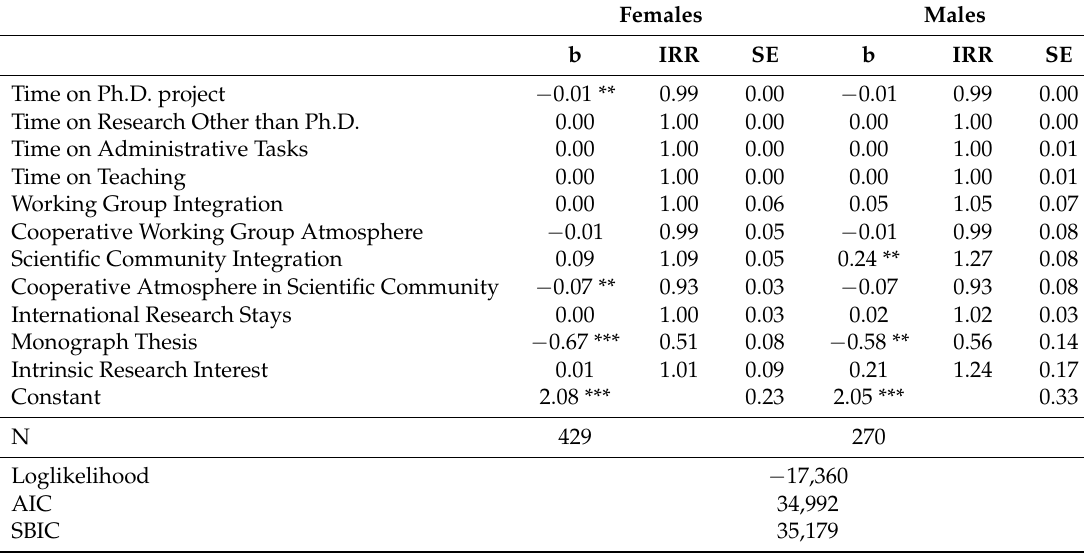
Table 2. Factors Associated with First Author Publications for Females and Males.